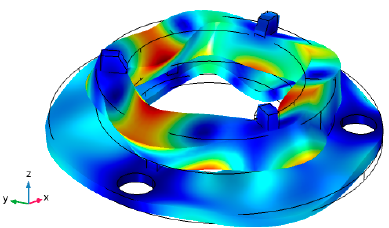
Figure 3. The modal shape of the actuator at 91.15 kHz.